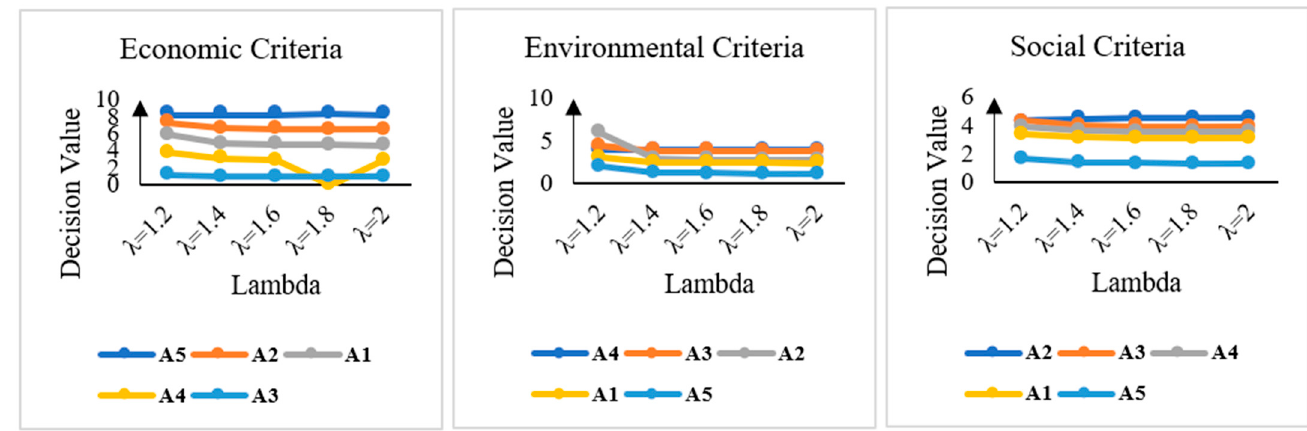
Figure 7. Effect of parameter λ in the CoCoSo method.